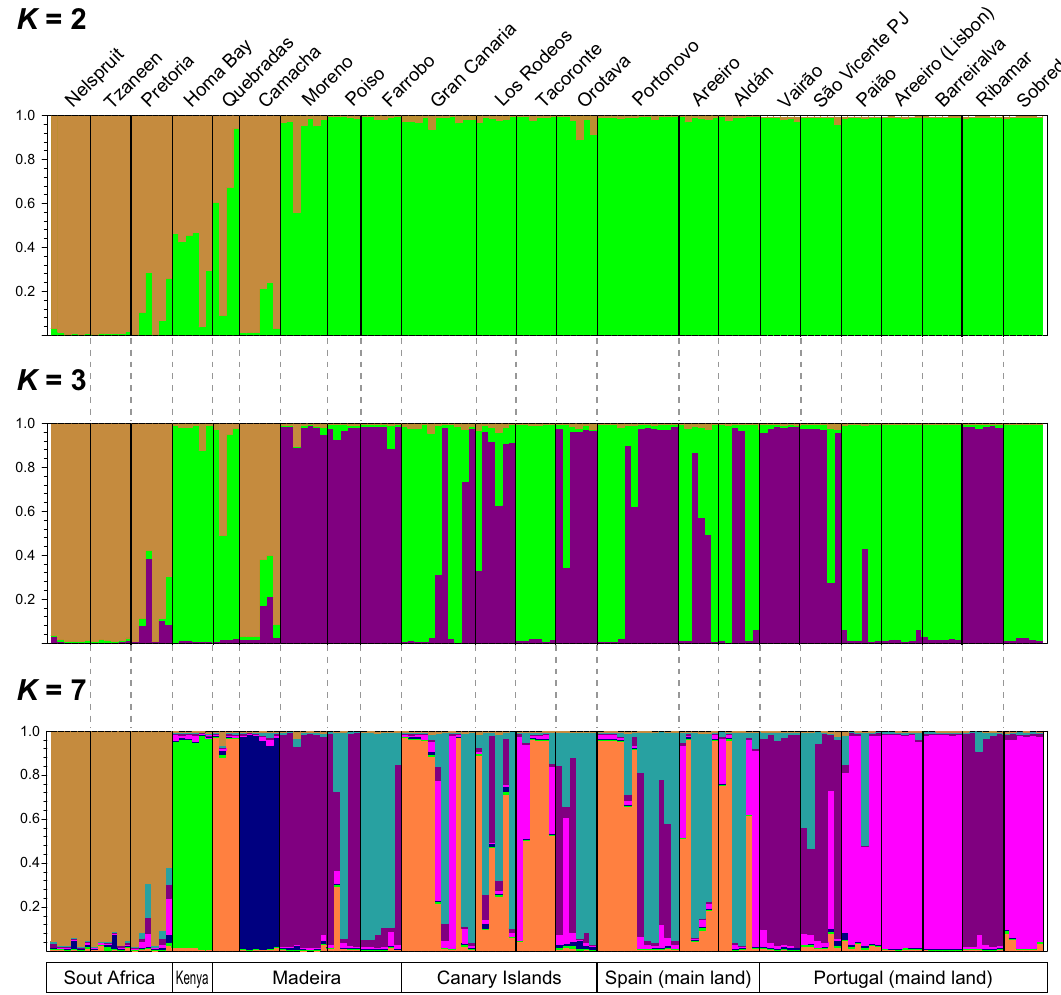
Figure 3. Bayesian clustering analysis of individuals genotyped with ten SSR markers in 23 populations of T. erytreae sampled in Africa, Spain, and Portugal. The assignment of individuals to genetic clusters inferred from STRU CTU RE 37 simulations are based on average membership coefficient ( Q ). Estimated membership fractions for each individual and population are shown for K = 2, 3 and 7. Selection of the number of clusters was based both on the K value at which the likelihood distribution began to decrease and the peak values of Δ K . Each individual is represented by a single vertical bar, with the colouring of each bar represents the stacked proportion of assignment probabilities to each genetic cluster. For K = 7, clusters 1, 2, 3, 4, 5, 6 and 7 are shown in green, beige, purple, pink, light blue, orange, and dark blue, respectively. Black vertical lines separate sample sites. Labels identify T. erytreae populations from old invaded areas in Africa, and newly invaded areas in the Iberian Peninsula and the invaded areas. Clusters 3 (in purple) and 4 (in pink) are mostly exclusive to the individuals from Madeira and Portugal mainland, although with some membership in the Canary Islands and Galicia. Cluster 5 (in light blue) and Cluster 6 (in orange) are represented by individuals from Madeira, the Canary Islands and Galicia, while the individuals from Camacha (Madeira) –the only ones that were collected from Casimiroa edulis La Llave & Lex. (Rutacea: Toddalioideae)—form exclusively Cluster 7 (in dark blue). Remarkably, Q fractions corresponding to Cluster 7 are present in the individuals from Nelspruit, Tzaneen, and some in Pretoria. The genetic diversity of T. erytreae populations was also assessed by means of a distance-based clustering method. The scored SSR allelic data obtained from the ten SSR loci developed in this study were used to calculate a genetic dissimilarity matrix and to compute a Neighbor Joining (NJ) tree. A preliminary dendogram constructed using only the African popula- tions of T. erytreae showed that the individuals from South Africa grouped together into a single cluster clearly separated from the Kenyan population. The robustness of the tree clustering was supported by the high boot- strap values obtained for nearly all branches (Fig. 4). To confirm the results obtained from the structure analysis a NJ tree under topological constraints was inferred using as initial tree the population structure of individuals from all the sampled areas with Q > 0.7. The remaining individuals were positioned (constraint) on that previous